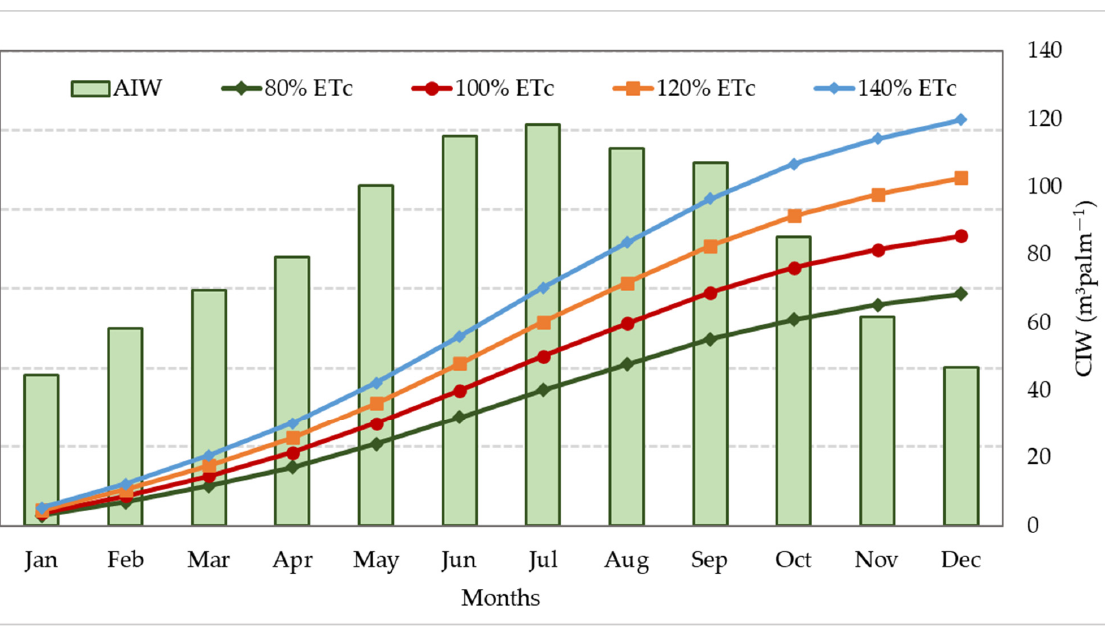
Figure 1. Average monthly applied irrigation water (AIW) at 100% ETc and the cumulative irriga ‐ tion water (CIW) applied at four irrigation water levels (80, 100, 120, and 140% ETc) during seasons 2020/2021 and